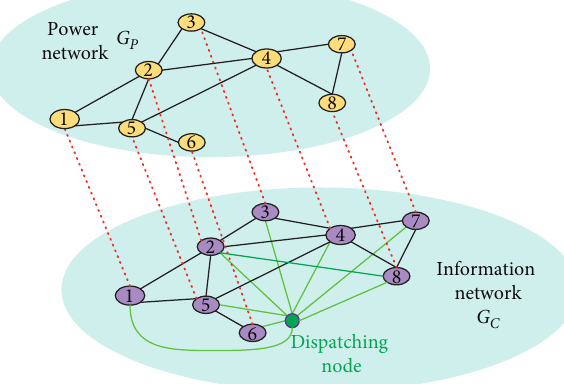
Figure 4: Example of the power CPS interdependent